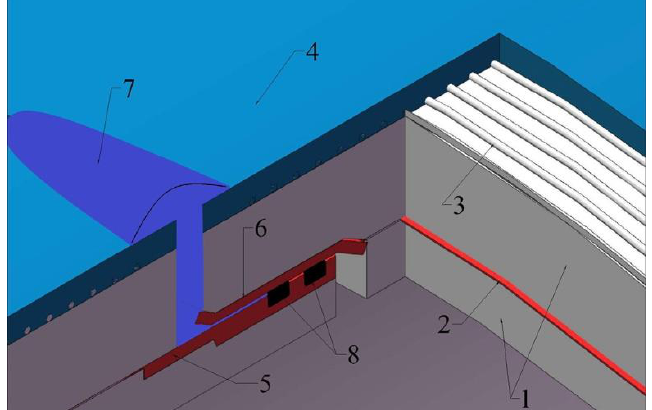
Figure 1. A 3D diagram of an embedded prestressed concrete cylinder pipe PCCPE: 1—Concrete core; 2—Cylinder; 3—Prestressing wires; 4—Mortar coating; 5—Spigot ring; 6—Bell ring; 7—Grout; 8—Rubber gasket.